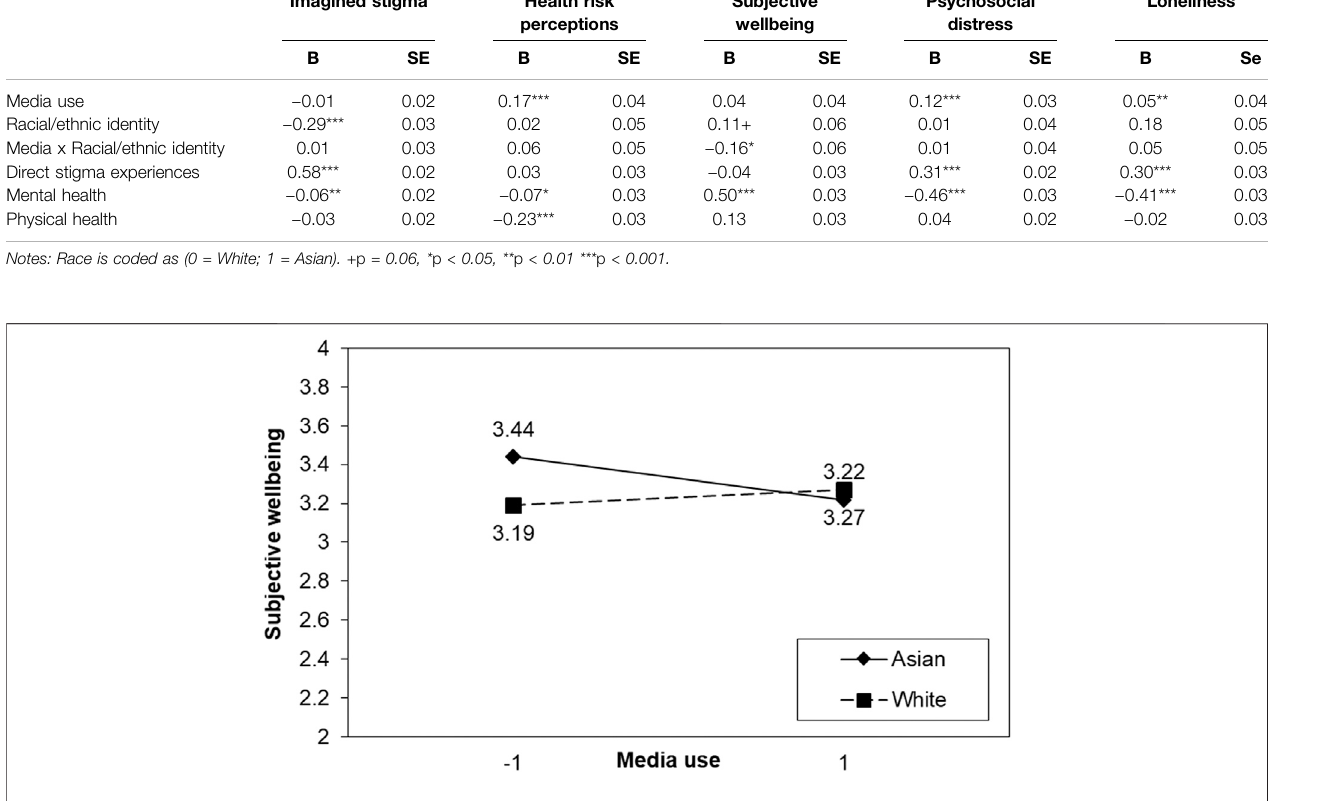
FIGURE 1 | Subjective wellbeing as a function of media use and racial/ethnic